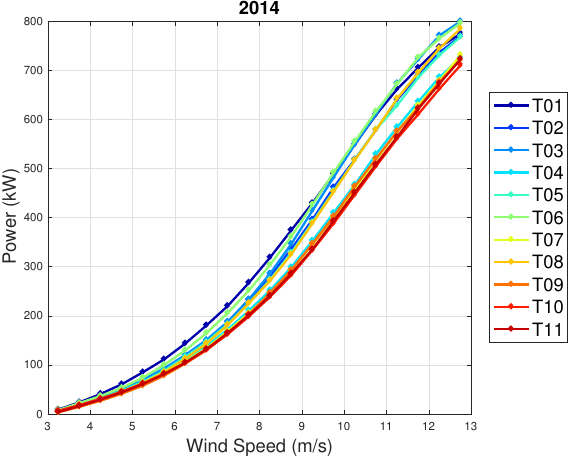
Figure 7. Average power curves for the year 2014: WF2.